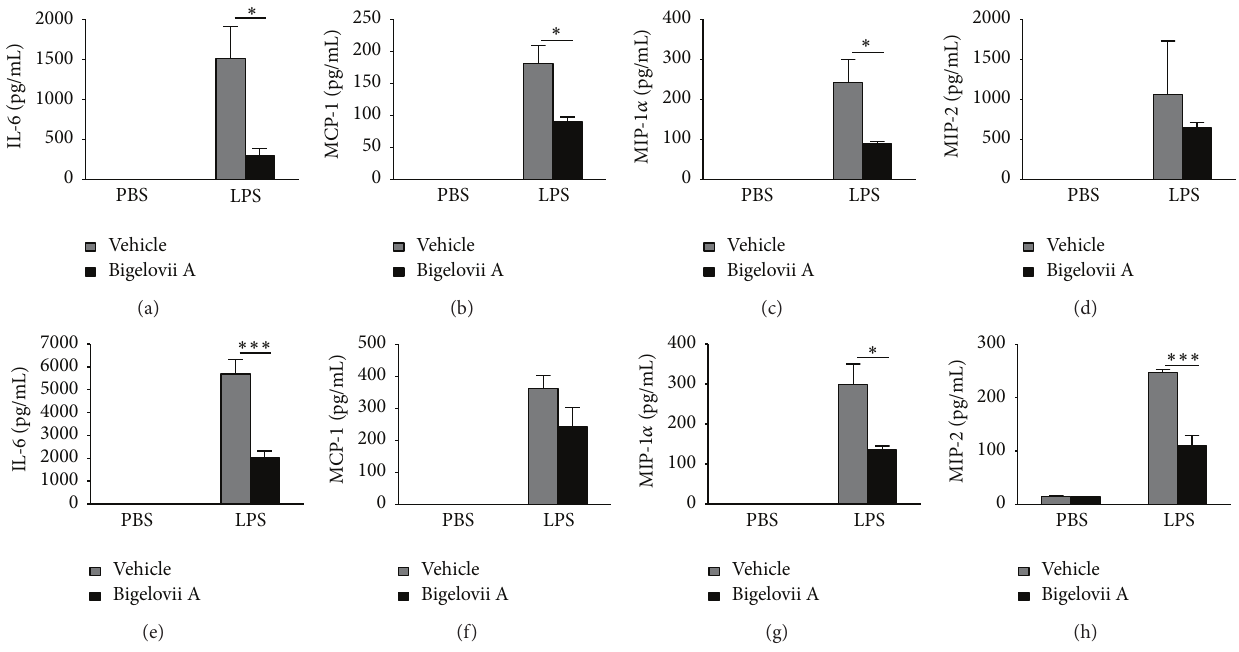
Figure 3: Effect of Bigelovii A on LPS-induced production of inflammatory mediators in BAL fluids. ALI was induced by intratracheal administration of LPS. 18 h or 60h later, BAL fluids were extracted and generation of IL-6 (a and e), MCP-1 (b and f), MIP-1 𝛼 (c and g), and MIP-2 (d and h) was measured. Results are reflected by means ± SEM [ 𝑛 = 3 for Vehicle plus PBS group (negative control) or Bigelovii A+PBS group, 𝑛 = 6 for LPS+Vehicle group (positive control), and 𝑛 = 5 for LPS+Bigelovii A group]. ∗ and ∗ ∗ ∗ indicated statistically significant difference, 𝑝 < 0.05 and 0.001,